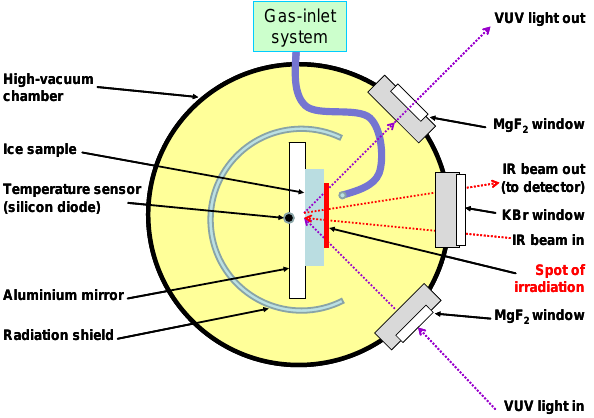
Fig. 1. Scheme of the laboratory setup illustrating the preparation of the ice film sample, its irradiation with VUV light by means of a hydrogen lamp and the measurement of IR spectra in the RAIRS